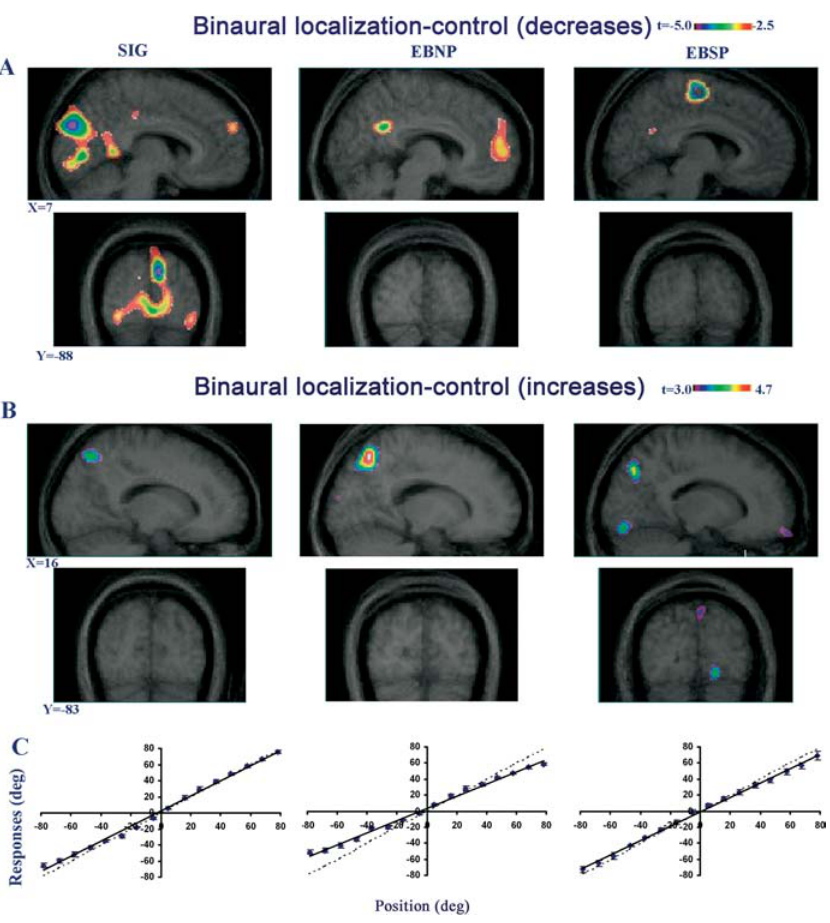
Figure 2. Binaural Sound Localization in PET Experiments Performed in the Three Groups of Subjects (A) CBF decreases. In the sagittal (upper image series) and coronal (lower image series) slices, a decreased CBF is observed in the visual cortex of SIG (striate and extrastriate cortices), for the contrast of BSL minus its control task. X and Y coordinates refer to standardized stereotaxic space. (B) CBF increases. In the sagittal (upper image series) and coronal (lower image series) images, a CBF activation peak is seen in the right ventral extrastriate cortex for the EBSP group, but not for the other two groups, for the contrast of BSL minus its control task. (C) Behavioral data. Behavioral results in the BSL task are presented (with SE bars). The dashed lines represent the ideal performance, and the solid lines indicate the best linear fit to the observed localization performance. All three groups were able to localize sounds accurately. DOI: